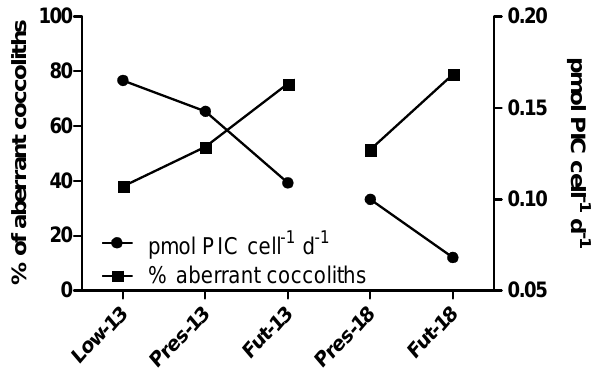
Fig. 6. Percentage of aberrant coccoliths (sum of the category 3 and 4) (solid squares) and cellular PIC production rate (solid circles) per CO 2 /temperature